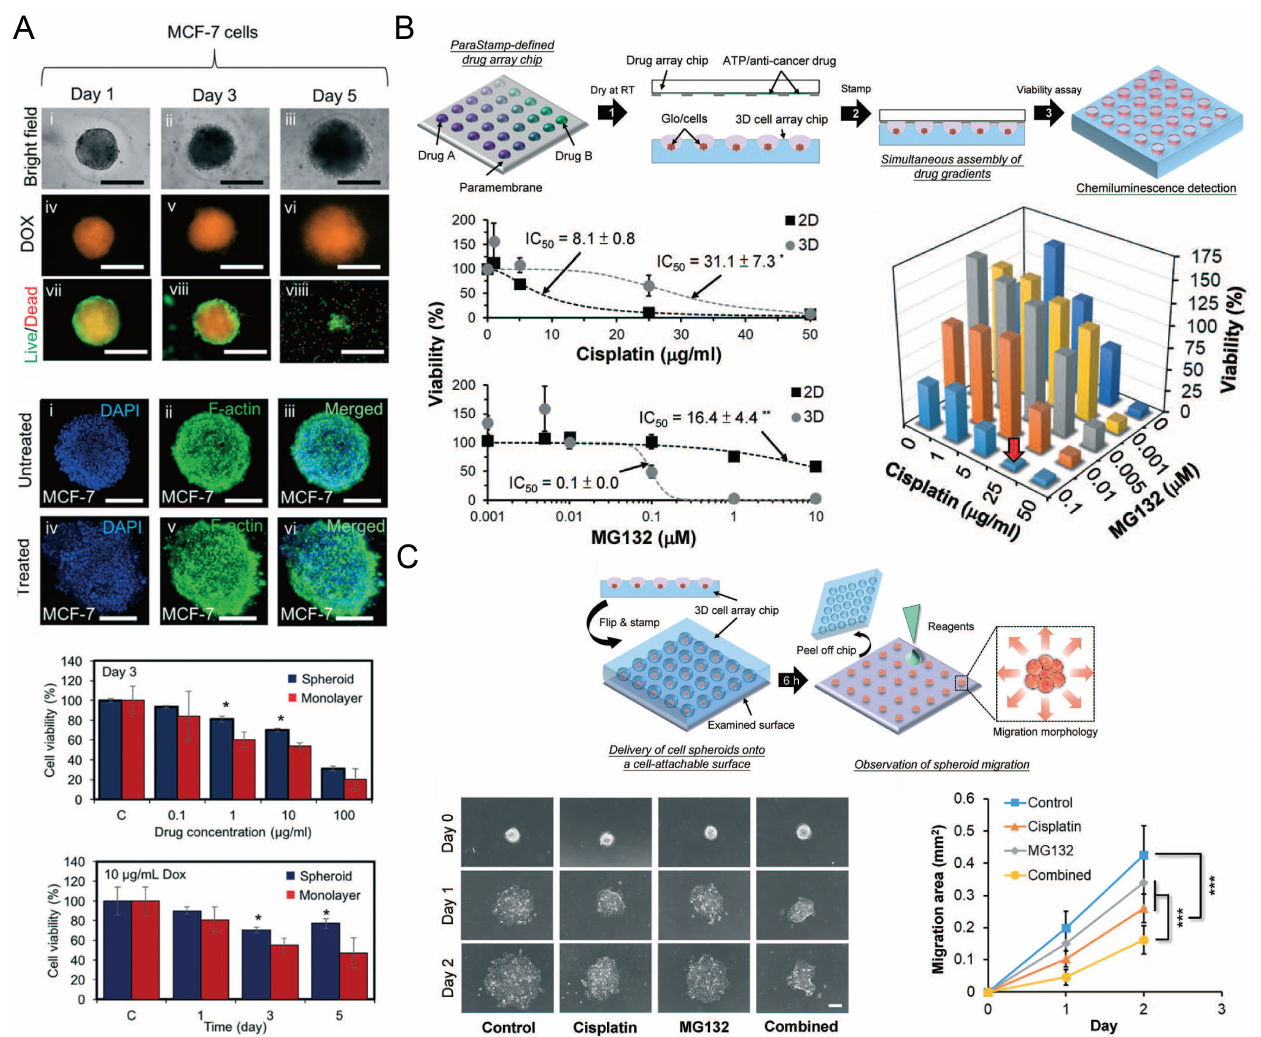
Figure 13. Cancer spheroids for drug screening. ( A ) The status of MCF-7 (human breast adenocar- cinoma cells) spheroids was monitored after they were treated with doxorubicin (DOX). The size of these spheroids was monitored by a bright field microscope, and the uptake of DOX and the live/dead status of MCF-7 cells were monitored by a fluorescent microscope. After 3 days of DOX treatment, spheroids with nucleus and F-actin stained were compared with control groups. The influ- ences of DOX concentration and treating time on the cell viability of spheroids and monolayers were investigated [87]. * p < 0.05. Scale bars: 500 µm. Reprinted (adapted) from [87]. Copyright (2018) with permission from Royal Society of Chemistry. ( B ) The schematic view of applying a 2D drug com- bination to SK-N-DZ (human neuroblastoma cell line) spheroids (upper), the influence of cisplatin and MG132 (a kind of proteasome inhibitor) on the cell viability of 2D and 3D culture mode (left below) respectively, and the influence of drug combination on the cell viability in spheroids after 24-h treatment (right below) [53]. ** p < 0.01. ( C ) The schematic view of investigating SK-N-DZ spheroid migration after drug treatment (upper), and the experimental pictures of SK-N-DZ spheroids with different drug treatments (control, cisplatin alone, MG132 alone, and a combination of cisplatin and MG132) (left below), and a comparison of the migration rate (right below) [53]. *** p < 0.001. Scale bar: 200 µm. Reprinted (adapted) from [53]. Copyright (2018) with permission from Royal Society of